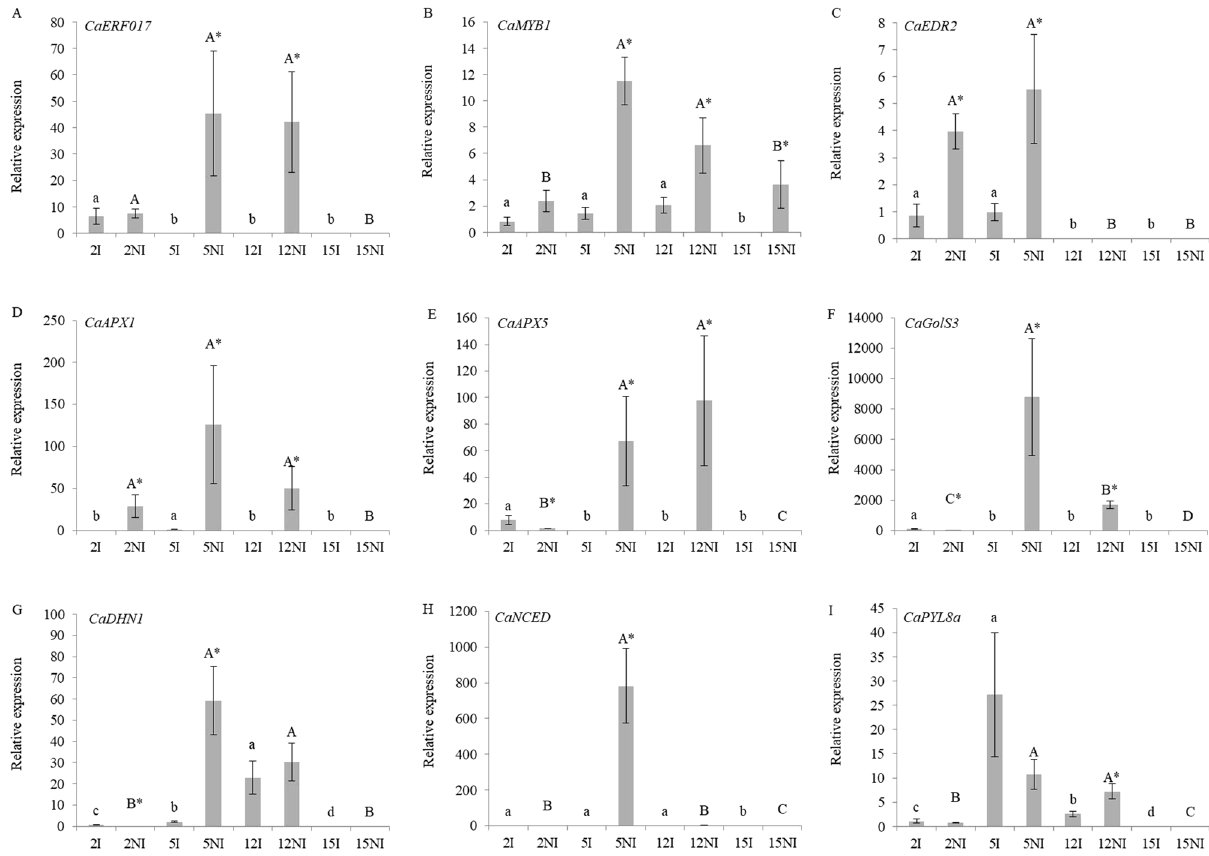
Figure 5. Gene expression profile under irrigated (I) and non-irrigated (NI) conditions. Gene expression was analyzed on leaves of 2, 5, 12 and 15 progenies. ( A ) CaERF017 gene expression; ( B ) CaMYB1 gene expression; ( C ) CaEDR 2 gene expression; ( D ) CaAPX1 gene expression; ( E ) CaAPX5 gene expression; ( F ) CaGolS3 gene expression; ( G ) CaDHN1 gene expression; ( H ) CaNCED gene expression; ( I ) CaPYL8a gene expression. Abundance of transcripts was normalized using CaUBQ10 gene expression as an endogenous control. The results were expressed using 15 I as the reference sample (Relative Expression = 1). Values of three replicates were presented as means ± SE (bars). Ranked results of the relative expression data of the progenies were analyzed using the non-parametric Kruskal–Wallis test followed by a pairwise comparison with the Mann– Whitney test. Significance level were established as p-values < 0.05, for both tests. Means followed by the same lowercase letter and averages followed by the same capital letter in each irrigation condition do not differ statistically from each other. Means followed by asterisks for even progeny are statistically